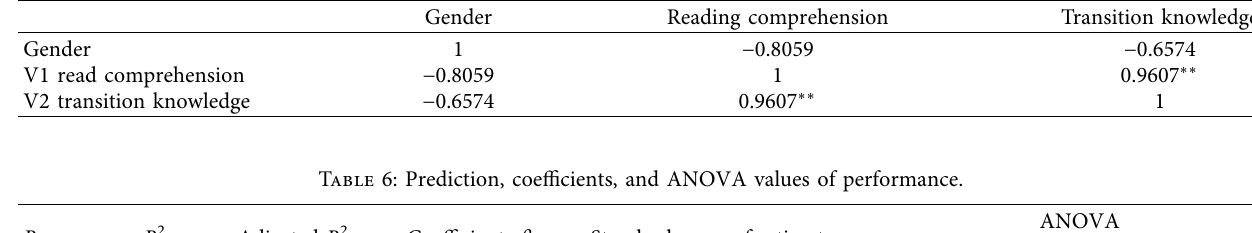
Table 5: Correlation between reading comprehension and transition word